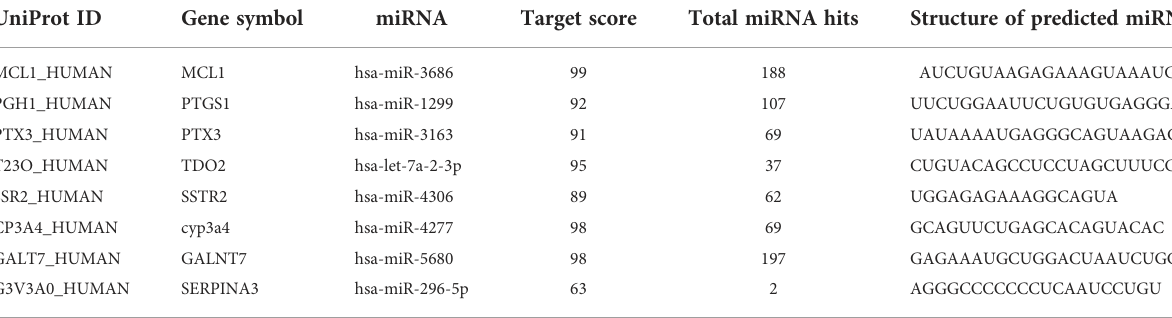
TABLE 4 miRNA targets for diabetes mellitus-associated